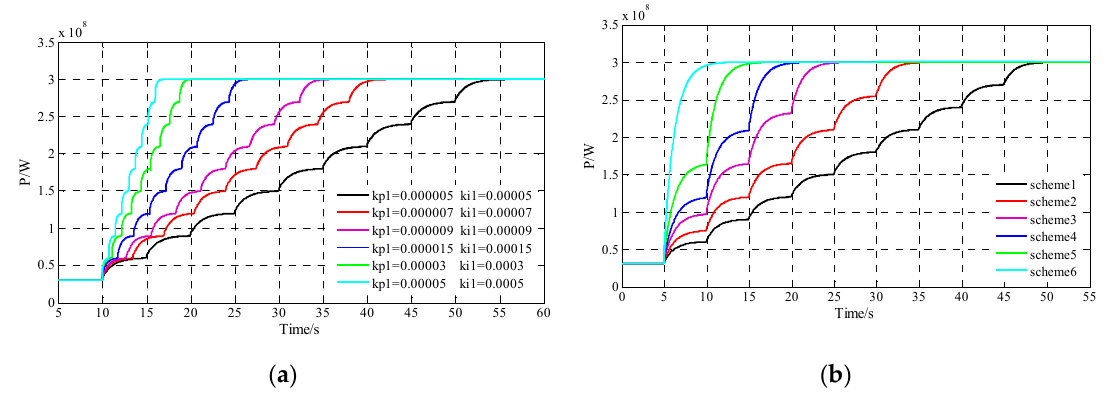
Figure 18. E ff ect of power control closed loop. ( a ) di ff erent response times; ( b ) di ff erent number of